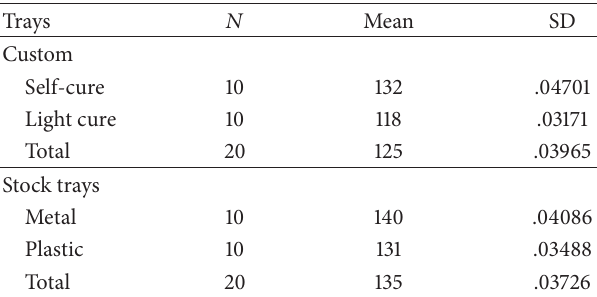
Table 3: Descriptive mean analysis of test impression materials ( 𝜇